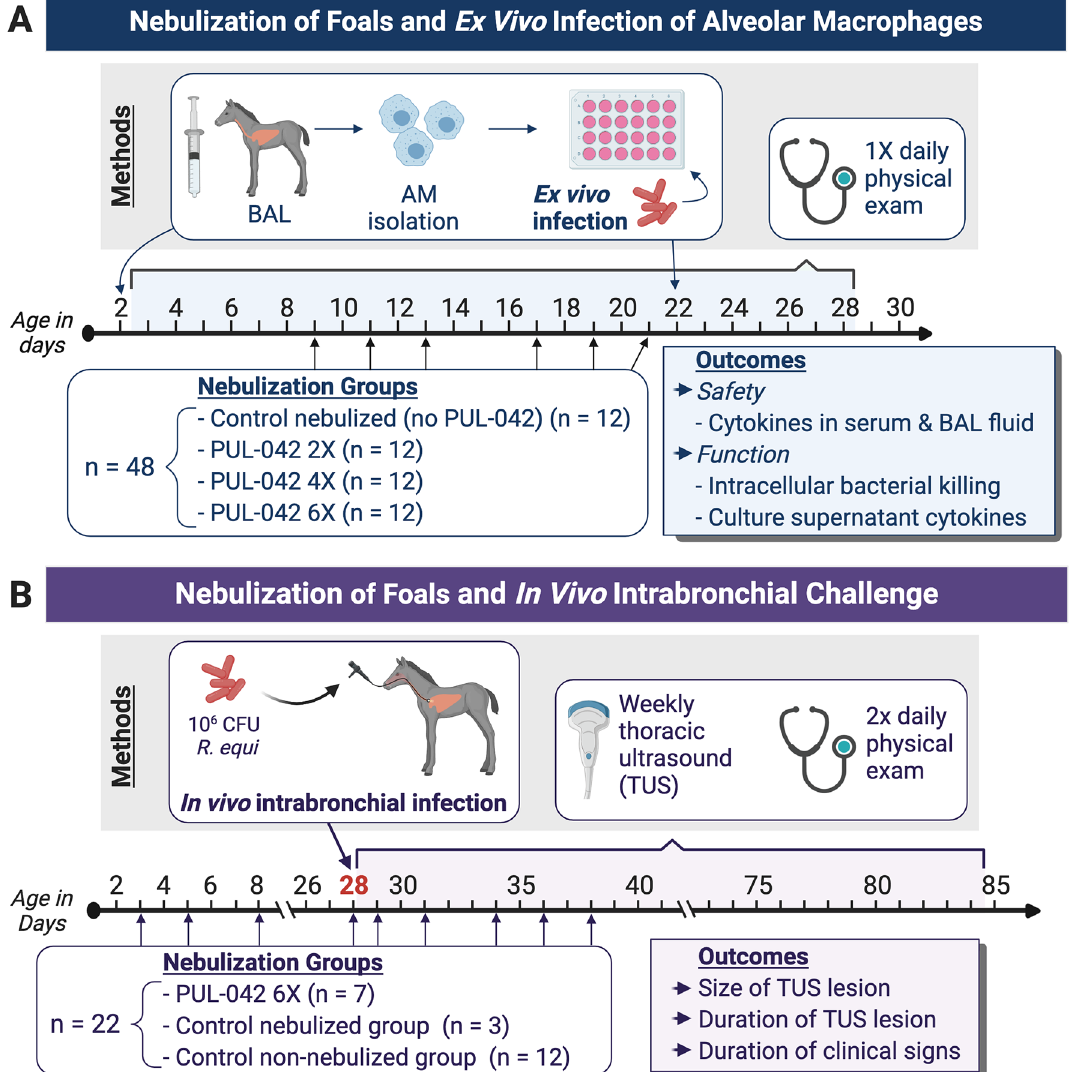
Figure 1. Study design. ( A ) Ex vivo study; All foals in this study were nebulized with either PUL-042 or placebo, and Rhodococcus equi infections occurred ex vivo in alveolar macrophages (AMs) obtained through broncho-alveolar lavage (BAL). Control group (n = 12) received 2.8% glycerol, the vehicle diluent for PUL-042; PUL-042 2× (n = 12) received 46 µg Pam2 and 68 µg ODN; PUL-042 4× (n = 12) 92.8 µg Pam2 and 136 µg ODN; PUL-042 6× (n = 12) 139.8 µg Pam2 and 204 µg ODN. BAL procedures for collection of fluid and AM were performed on ages 2 (before nebulization) and 22 days (24 h following the last nebulization). Nebulizations started 1 week after the first BAL (approximately day 9 of age), and each foal received 6 nebulizations in a 2-week interval. Infections were performed ex vivo in AMs. ( B ) In vivo study; PUL-042 6× (n = 7) received 139.8 µg Pam2 and 204 µg ODN; control-nebulized group received 2.8% glycerol (n = 3); and control non- nebulized group (n = 12) did not receive nebulization. Infections were performed in vivo on day 28 of age, and foals were in the study until approximately 12 weeks of age. Nebulized foals received 9 nebulizations: 4 before and 5 after challenge at 28 days of age. Following challenge, twice daily physical examination, and weekly thoracic ultrasounds (TUS) were performed in all foals. At 12 weeks of age or whenever the foal recovers from clinical pneumonia if after 12 weeks of age, a tracheal wash was performed to confirm complete recovery of pneumonia by demonstrating absence of cultured R. equi and evidence of normal cytology on tracheal-wash fluid. Created with of the resultant pneumonia in foals (Fig. 1B). All foals in all groups experimentally infected were confirmed having R. equi clinical pneumonia based on our case-definition: ≥ 2 physical signs, evidence of lung abscessa- tion, and both presence of R. equi and cytologic evidence of suppurative pneumonia with presence of degenerate neutrophils in T-TBA samples. Twenty-two additional foals were randomly assigned to 3 groups: control not nebulized, nebulized before and after infection with 2.8% glycerol (PUL-042 diluent), and nebulized before and after infection with PUL-042. Foals that were nebulized with PUL-042 following the infection had a significantly